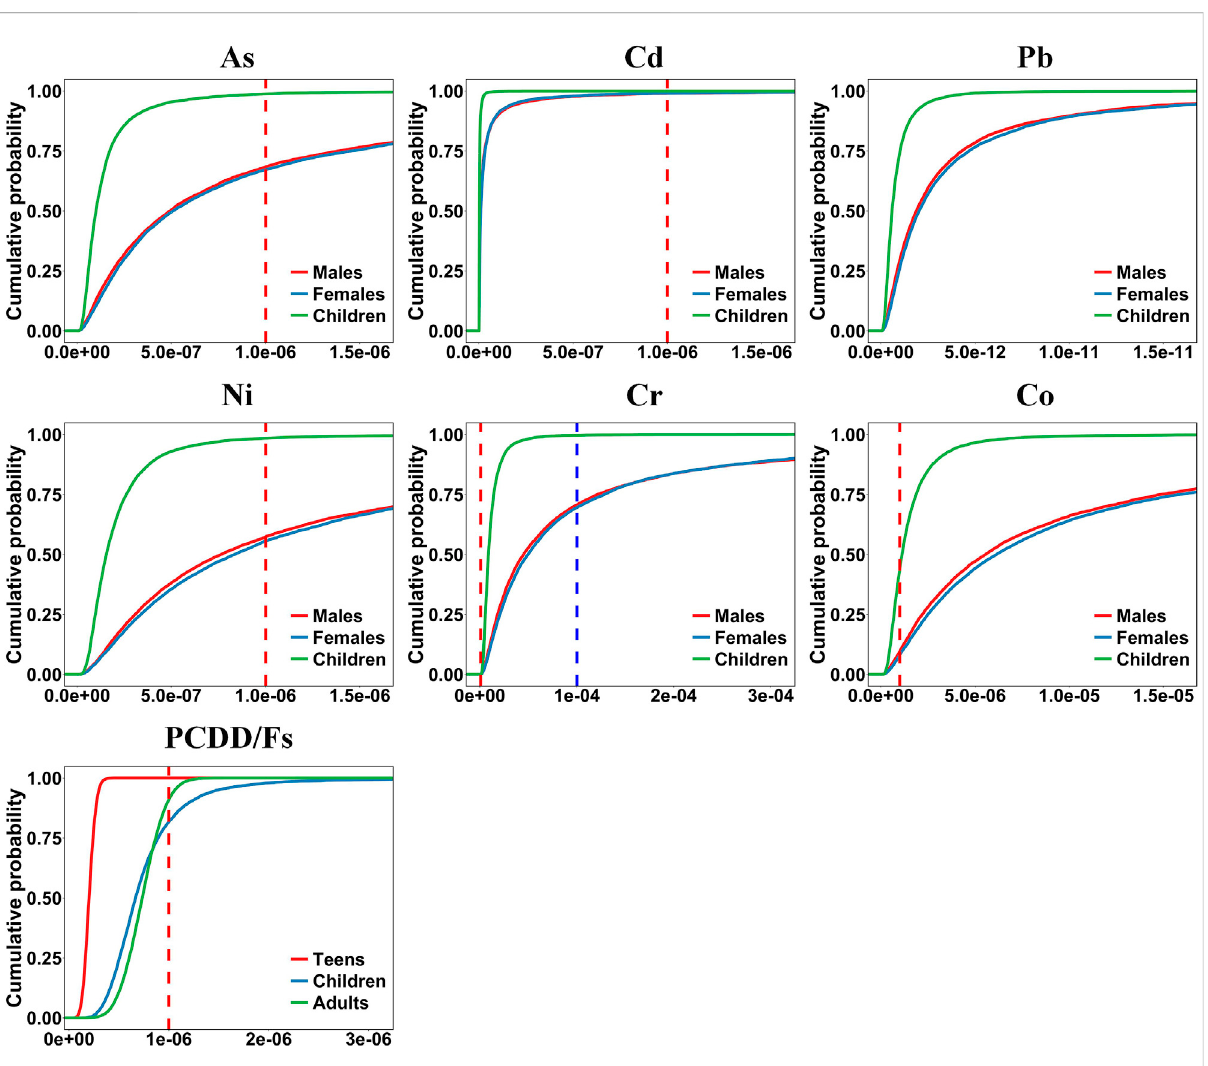
FIGURE 10 Cumulative probabilities of the total carcinogenic risk for different population groups (Note: dotted lines represent acceptable levels).